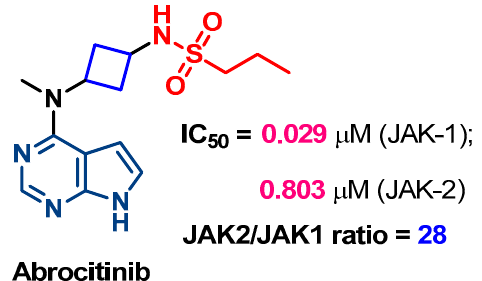
Figure 12. JAKs inhibitory activities of abrocitinib.